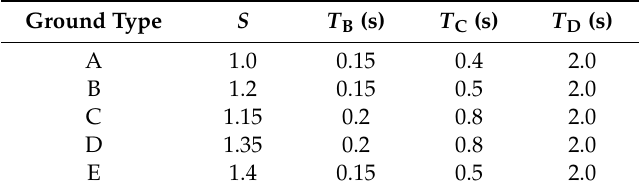
Table 3. Values of parameters describing elastic response spectra